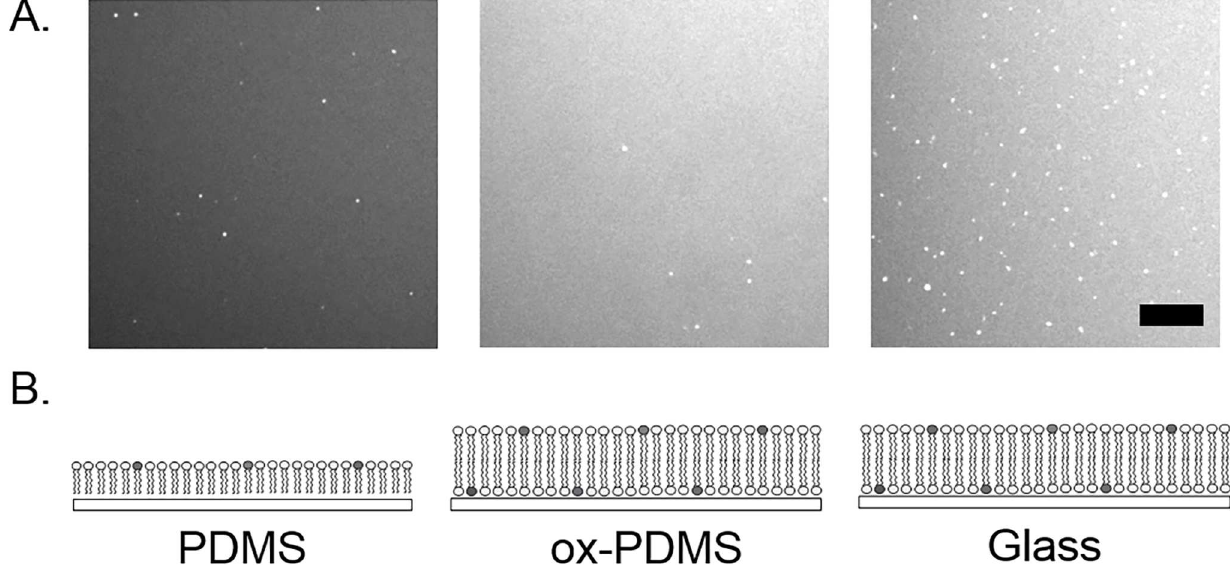
Fig 1. Representative confocal fluorescence images of lipid layers formed on PDMS, ox-PDMS, and glass immediately after preparation. A uniformly fluorescent lipid layer was present on all the surfaces after the fusion of SUVs. The layer on PDMS appearedto have a qualitatively lower intensity comparedto the layers on ox-PDMS and glass. Unfusedsmall unilamellar vesicles (SUV) appearedas bright compact spots on the lipid layers. The lower images are schematic diagrams of the configurationof the lipid moleculeson the respective surfaces. Lipidsform a monolayeron the PDMS, bilayerson ox-PDMS, and bilayerson glass. Scale bar 10 μ